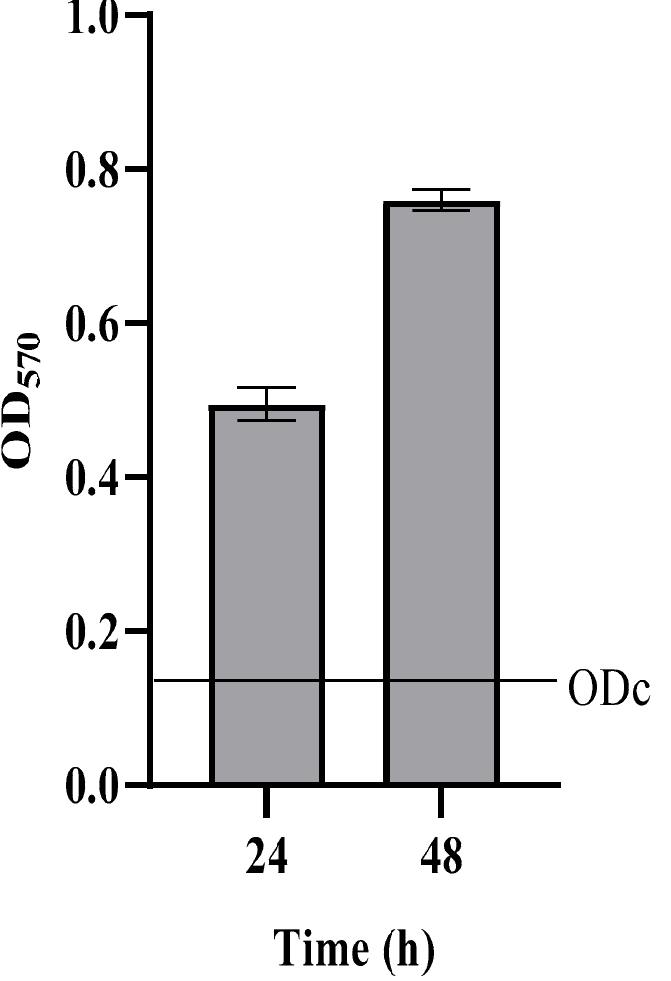
Figure 1. Total biomass of C. auris biofilms after 24 and 48 h of incubation. ODc = optical density cut off value (for details see Section 4). Data are the mean of three independent experiments ±